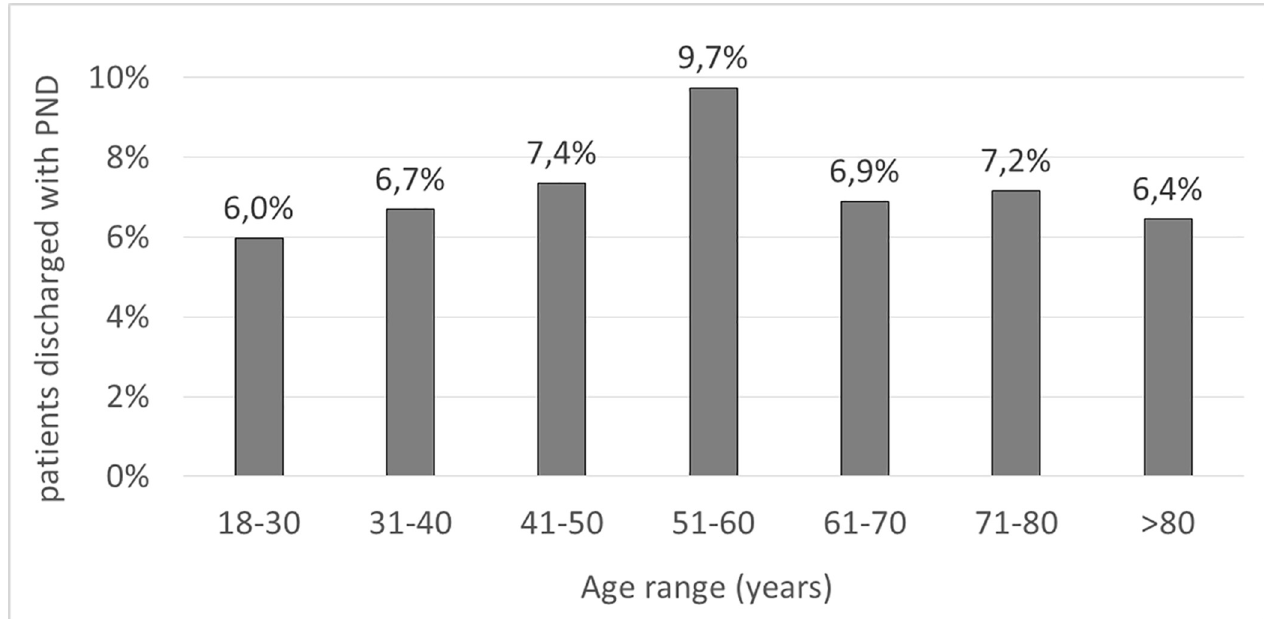
Fig 1. Percentage of patients discharged with DoC among ICU survivors stratified by age. https://doi.org/10.1371/journal.pone.0253225.g001 sepsis (1.9% vs 5.6%). These patients were also more frequently unconscious (91.7% vs 57.5%), intubated (87.7% vs 71.3%) and mechanically ventilated (86.8% vs 68.5%) at ICU admission with a lower mean Glasgow Coma Scale Score on ICU admission (4.8 ± 2.7 vs 8.8 ± 4.6 points, respectively). All of these differences were statistically significant ( p < 0.001).